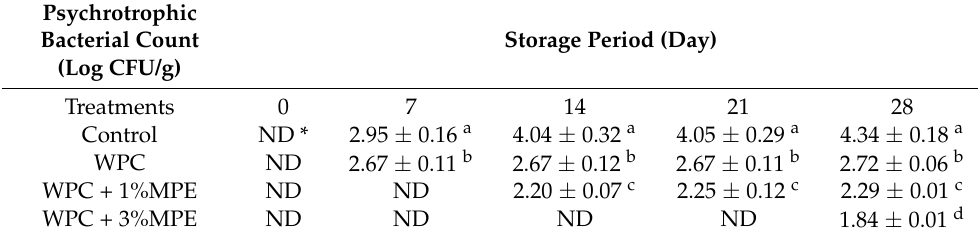
Table 4. Psychrotrophic bacterial count (CFU/g) of broccoli fresh-cuts treated with different coating (WPC = whey protein concentrate alone, WPC + 1% MPE = whey protein concentrate + mango peel extract at 1% and WPC + 3% MPE = whey protein whey protein concentrate + mango peel extract at 3%) during 28 days of cold storage.